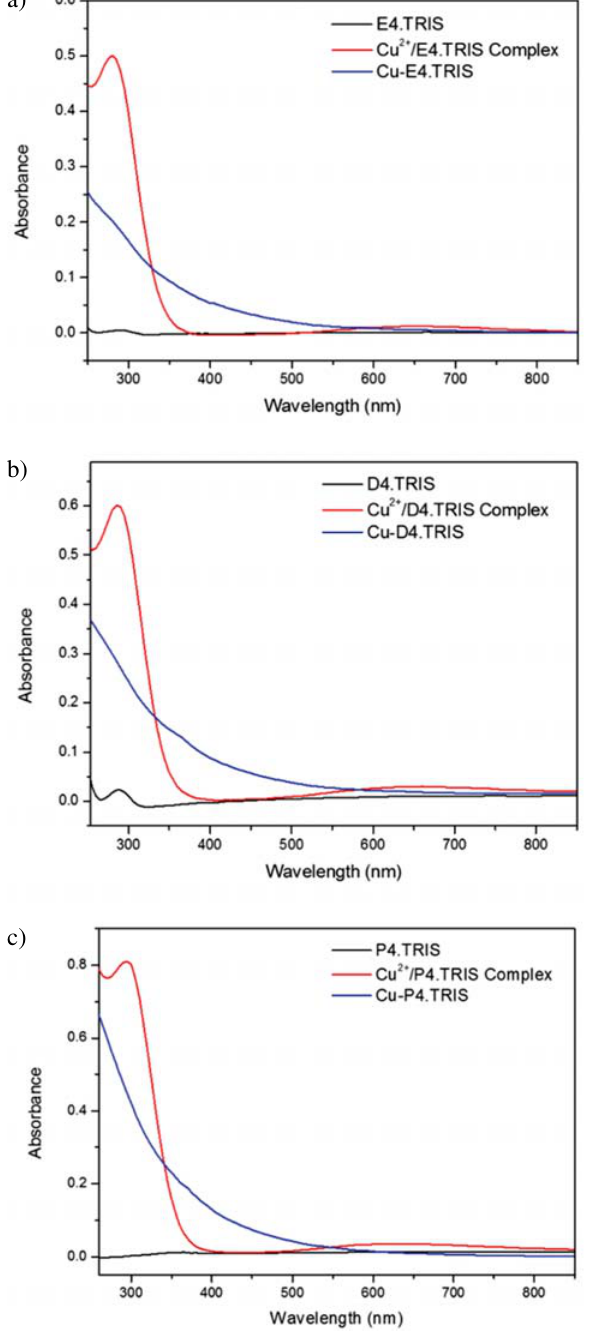
Figure 8. UV-Vis absorption spectra of the formation of (a) Cu- E4.TRIS; (b) Cu-D4.TRIS, and (c)